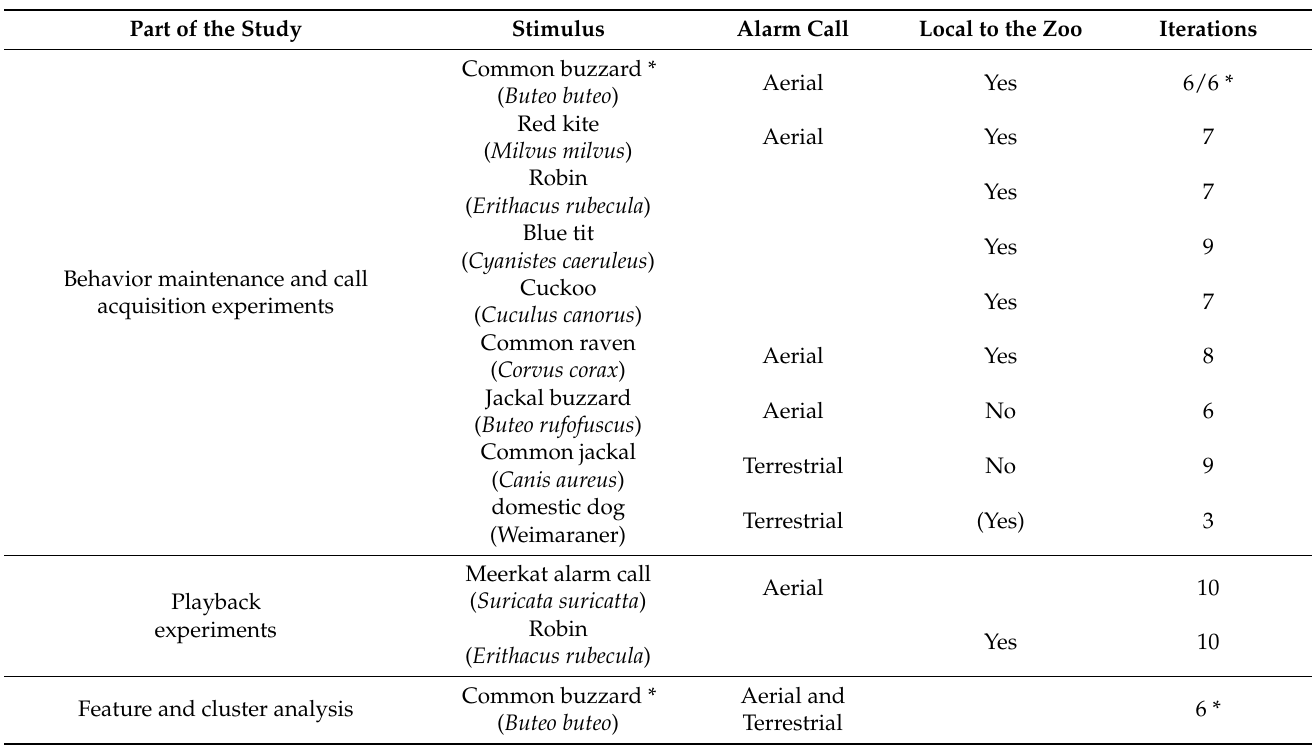
Table 1. Overview of the different experiments. Stimuli marked with an * were additionally combined with a visual stimulus. Since dogs are allowed in the zoo, they are considered